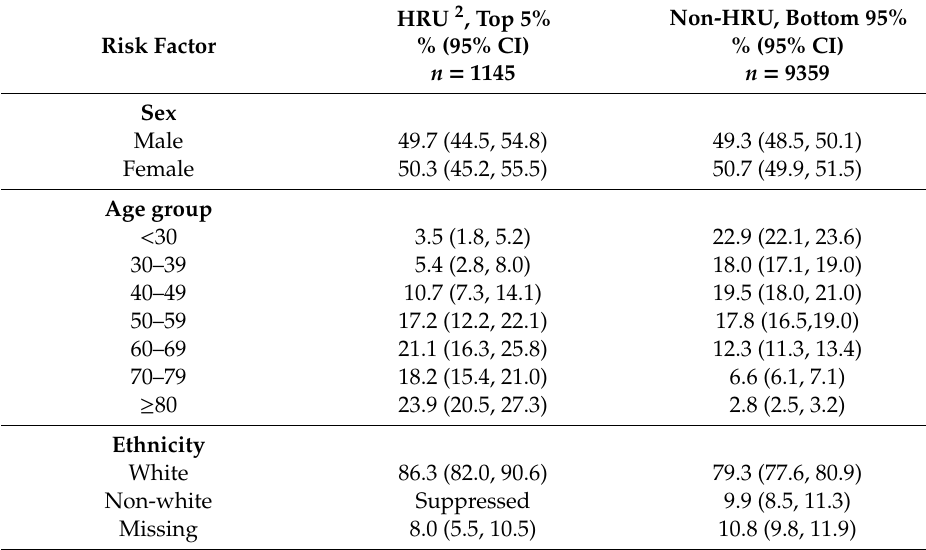
Table 1. Weighted baseline characteristics of the external validation cohort 1